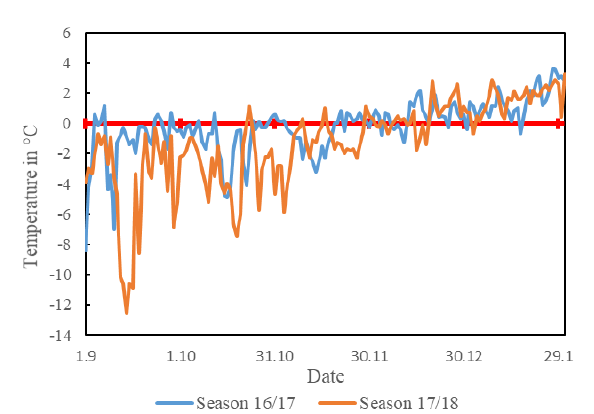
Figure 15. Season 2016/17 and 2017/18: temperatures. Source: rp5.ru